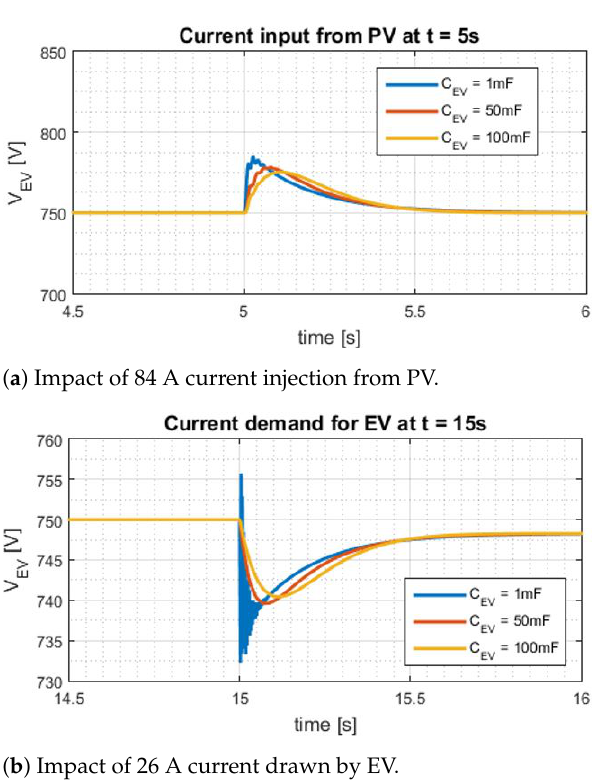
Figure 14. EV side voltage of DC nanogrid due to power mismatches. Assuming that the allowed voltage fluctuation is ± 5% from 750 V, based on the simulations with different sizes of capacitor, the required capacitor for each side can